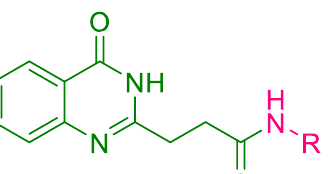
Figure 28. Quinazolinone conjugated to elastin-based peptide fragments.